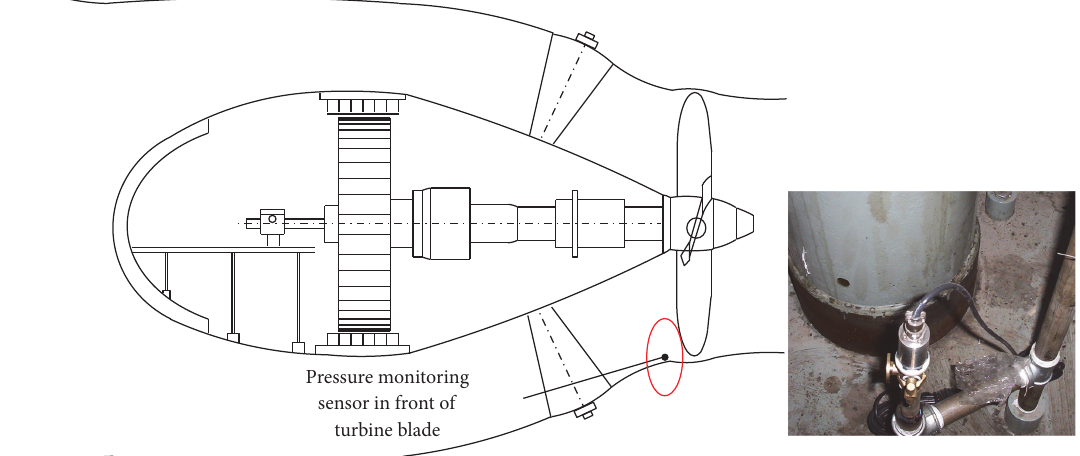
Figure 11: Specific layout of measuring point in hydroelectric turbine.